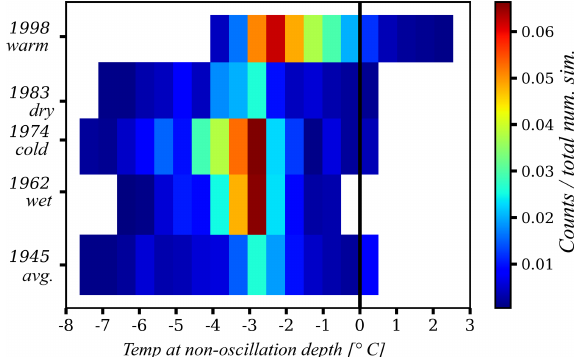
Figure 12. The 2-D histogram of climate condition (years) and tem- perature at h T -non-oscillation depth. Only SCDs that have reached the h T -non-oscillation condition are included. The black line repre- sents the 0 ◦ C